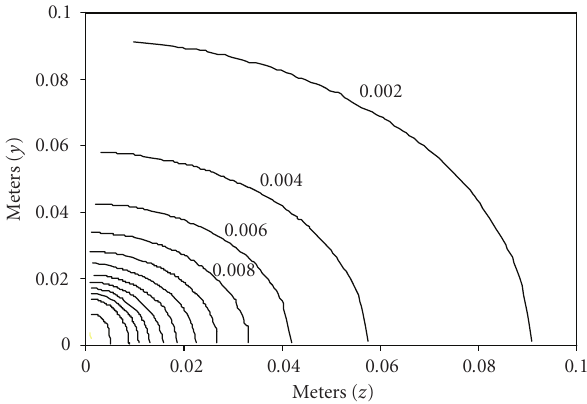
Figure 8: Transient temperature increases produced at the region of maximum SAR near the 3 cm